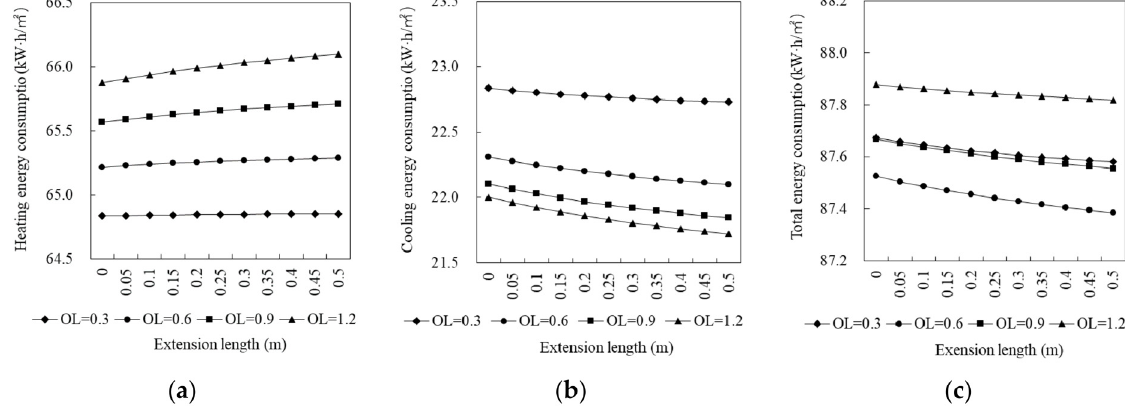
Figure 14. Relationships between extension length and energy consumption: ( a ) heating; ( b ) cooling; ( c ) total.